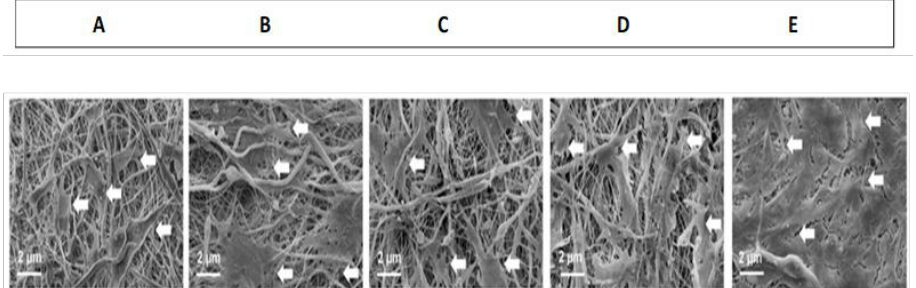
Figure 3. SEM images of MC3T3-E1 adhered on the nanofibrous scaffold after 2 days. ( A ) PCL/HA; ( B ) ASA/PCL/HA; ( C ) BSANps/PCL/HA; ( D ) ANPs/PCL/HA; ( E ) ANPs/ASA/PCL/HA The arrows indicate lamellipodia and cell outlines. (Reproduced with permission from [37]; Copyright 2022, Elsevier).